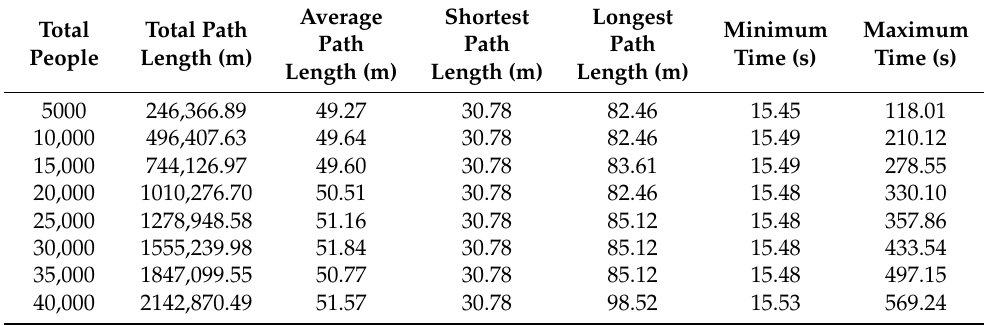
Table 4. Experimental results with different numbers of initial